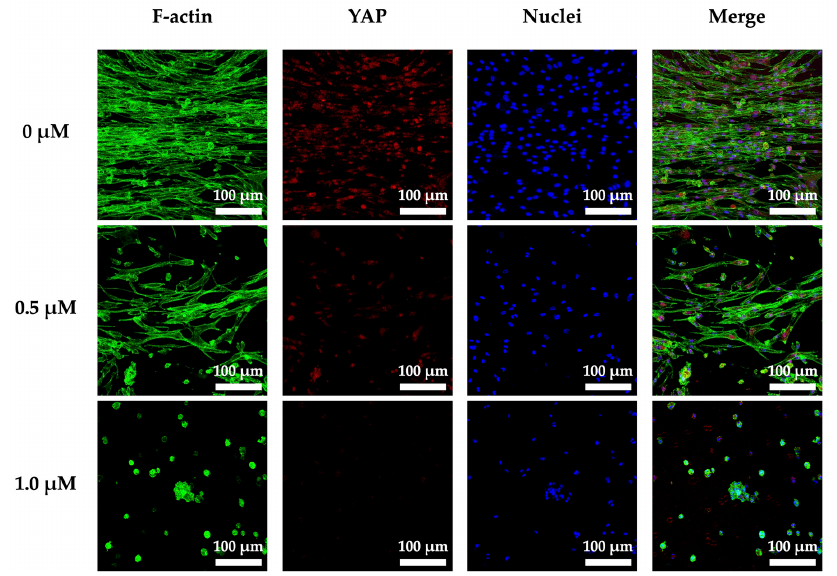
Figure 10. Immunofluorescence staining of YAP expression of hPDLs-laden CS1 auxetic scaffolds with cyclic tensile stimulation and YAP inhibitor (Veteprofin: 0, 0.5, and 1.0 μ M) for 3 days. The scale bar is 100 μ m.